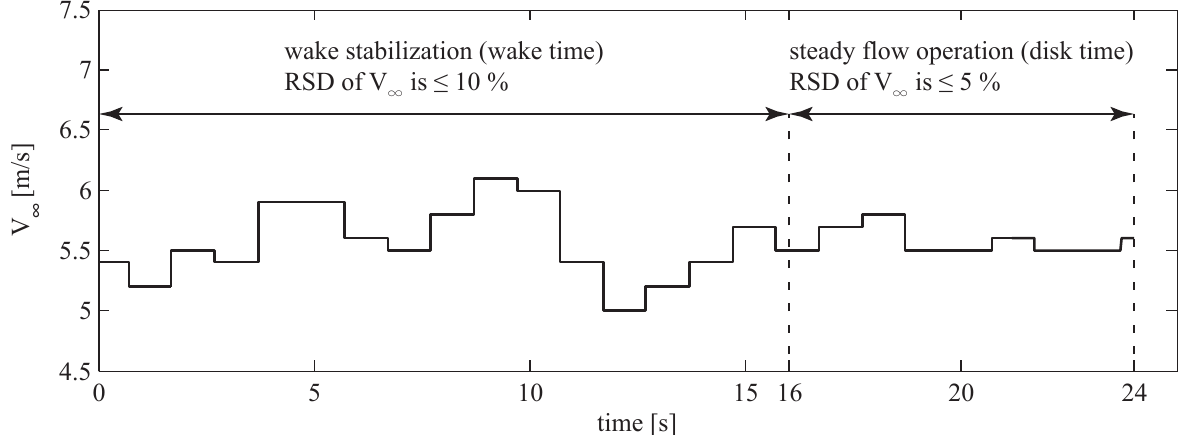
Figure 5. Allowed variations of the asymptotic wind speed during steady conditions. Illustration of the wake time and disk